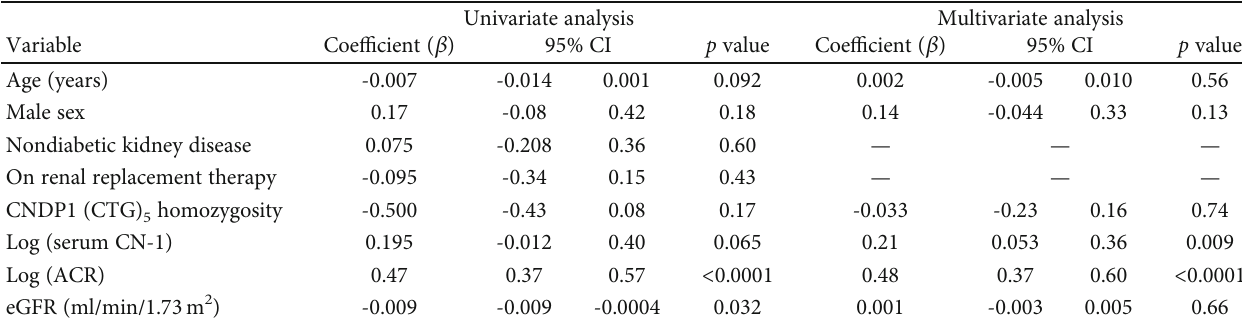
Figure 3: Distribution of serum CN-1 (left y -axis) and urinary CN-1 concentrations (right y -axis) according to the CNDP1 (CTG) homozygous genotype versus other CNDP1 genotypes ( > CTG) in healthy subjects ( n = 24 ) (a) and in patients with T2DM ( n = 85 ) (b). 5 Results are expressed for each individual patient. The lines represent the median and IQR. Note that the units on the left and right y -axes are expressed in μ g/ml and ng/ml, respectively. Table 2: Summary of univariate and multivariate regression analyses predicting urinary CN-1 concentrations in T2DM and nondiabetic CKD patients ( n = 104